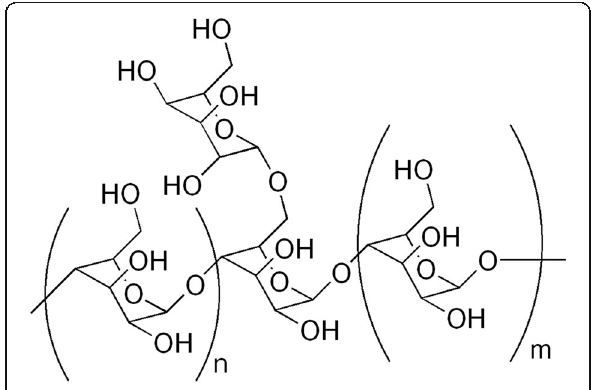
Fig. 1 Chemical structure of